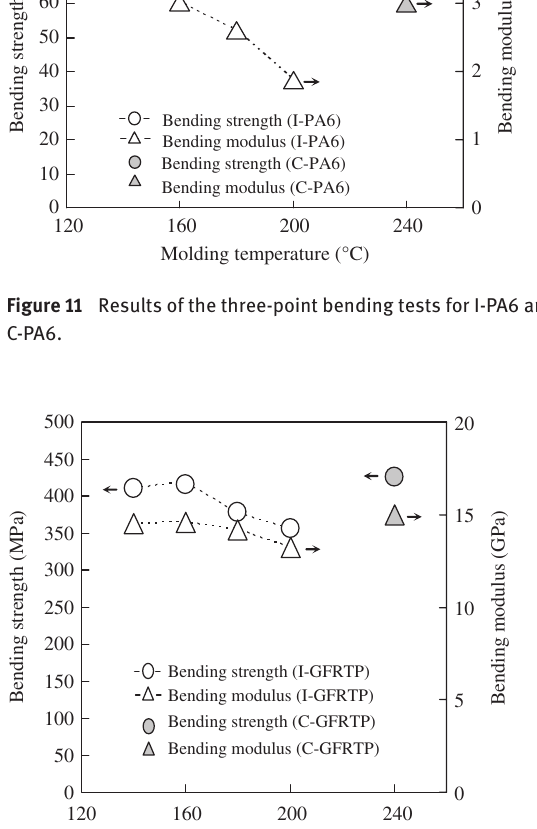
Figure 14 Bending modulus of I-GFRTP and C-CFRTP for molding temperature.